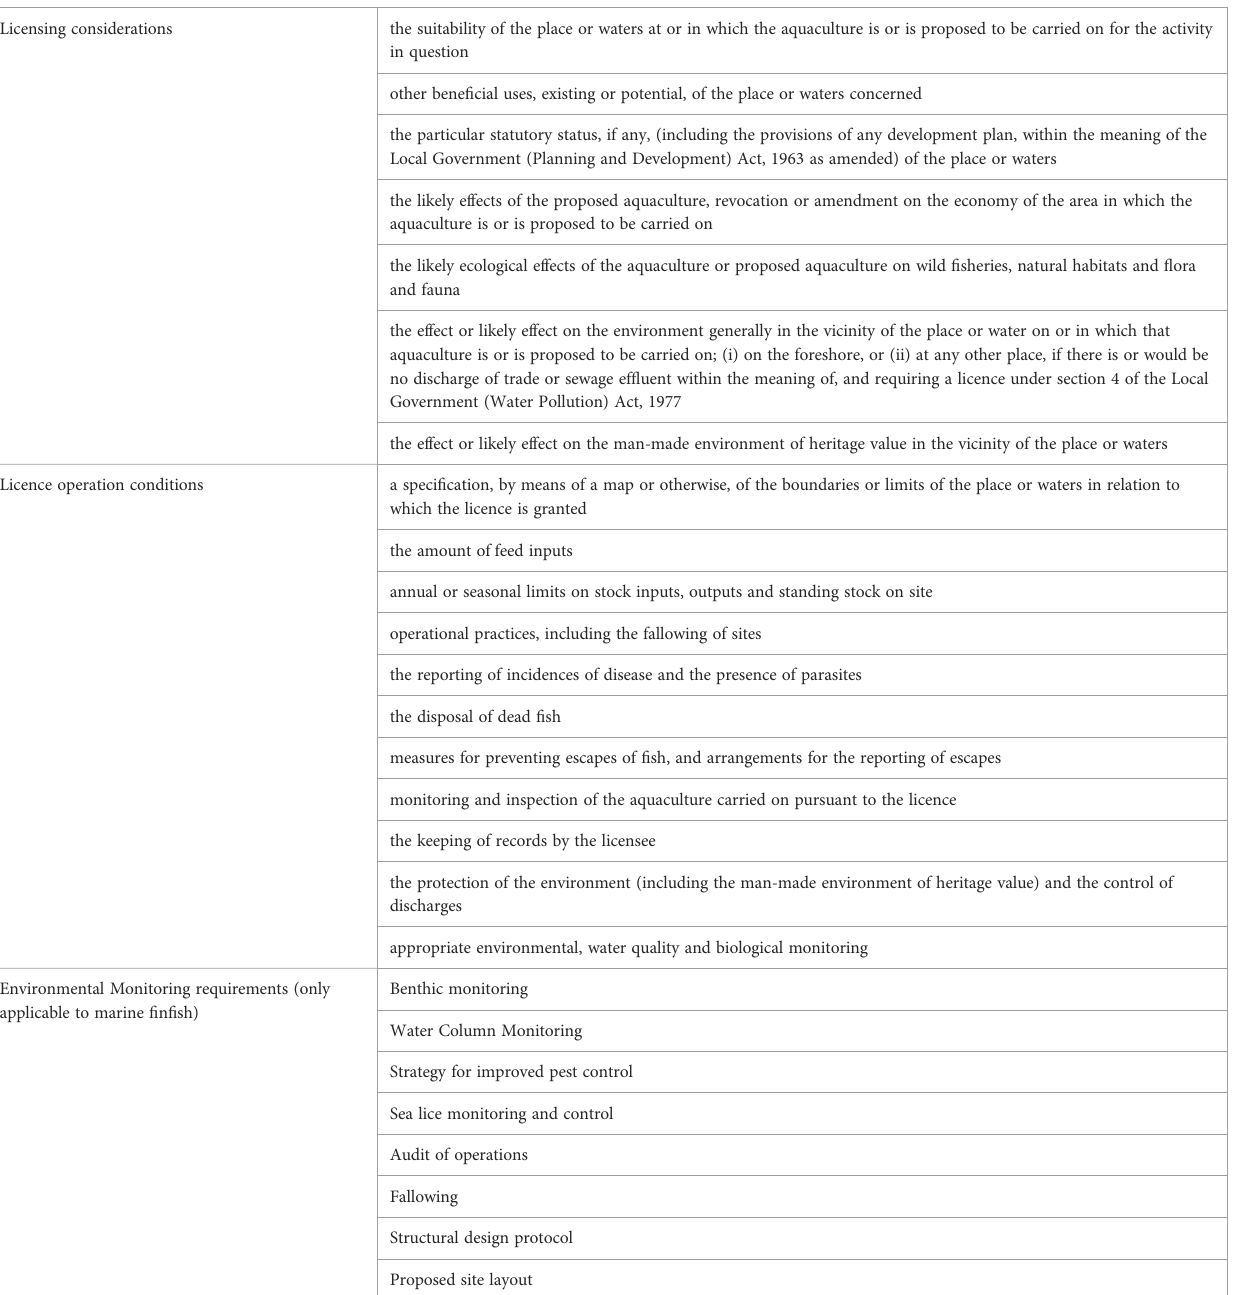
TABLE 3 Licence processing and monitoring under the Fisheries Act